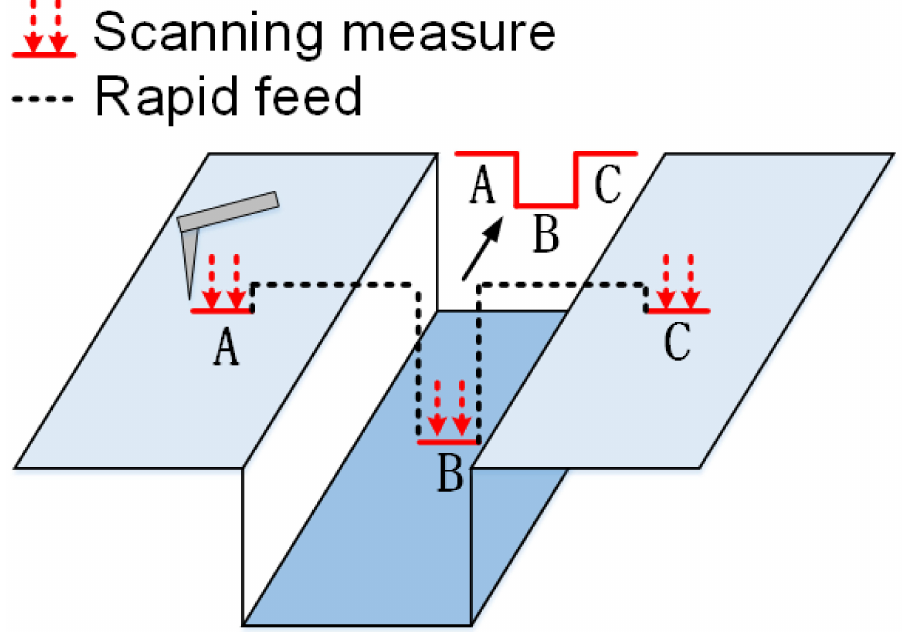
Figure 10. Position to be